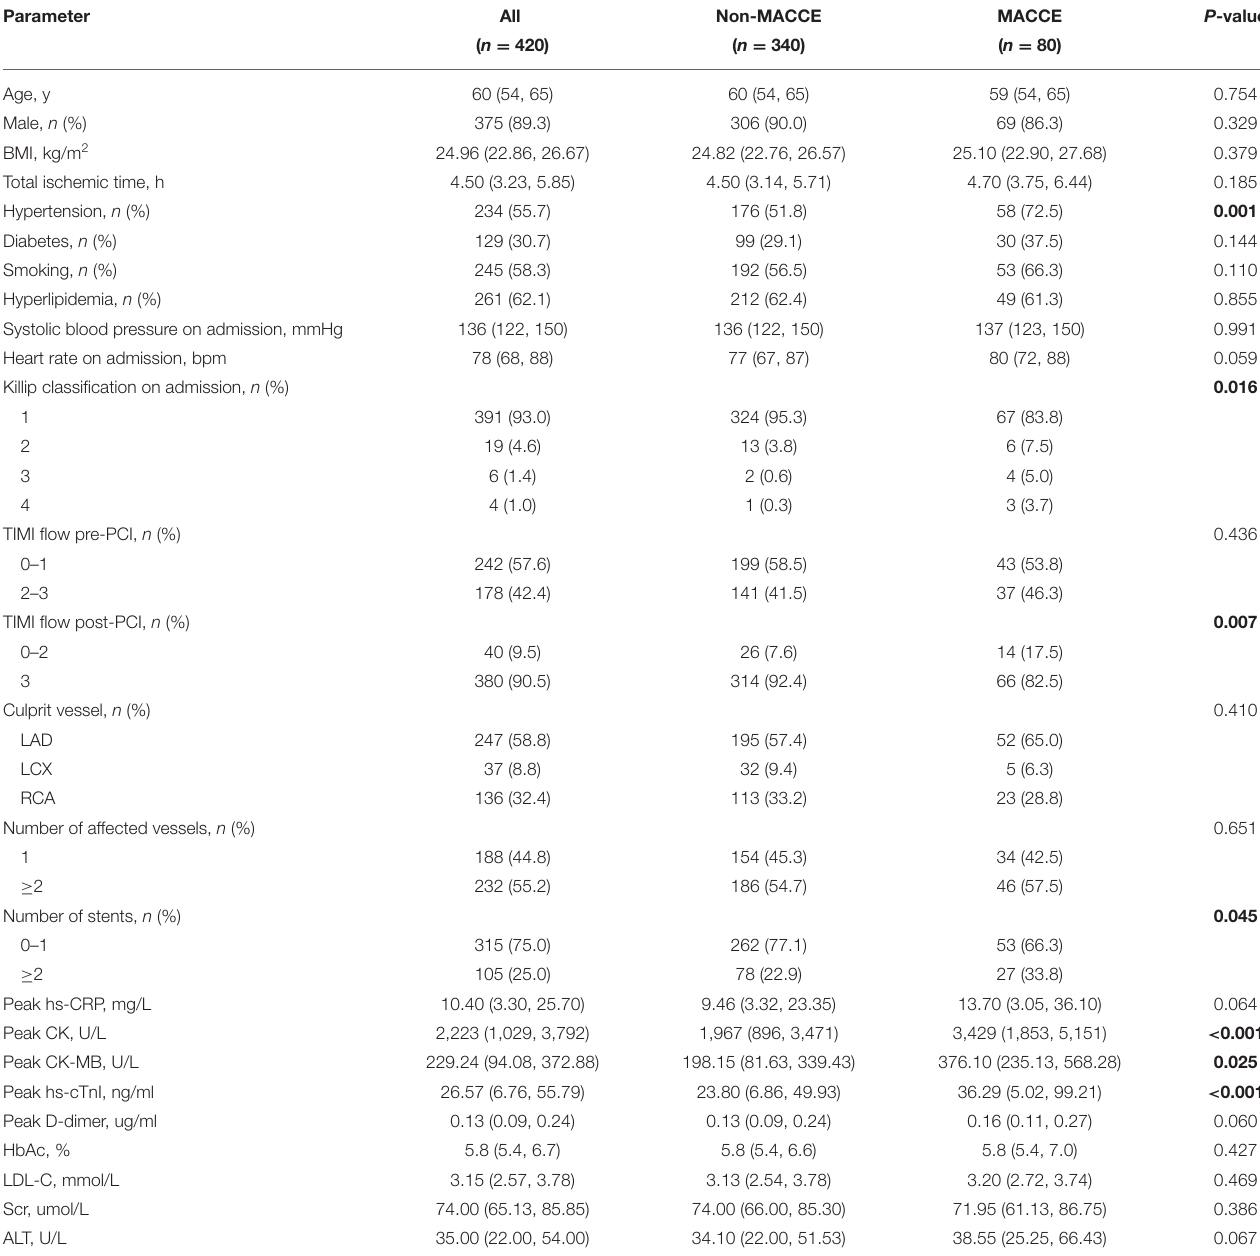
TABLE 1 | Clinical characteristics of patients with STEMI.